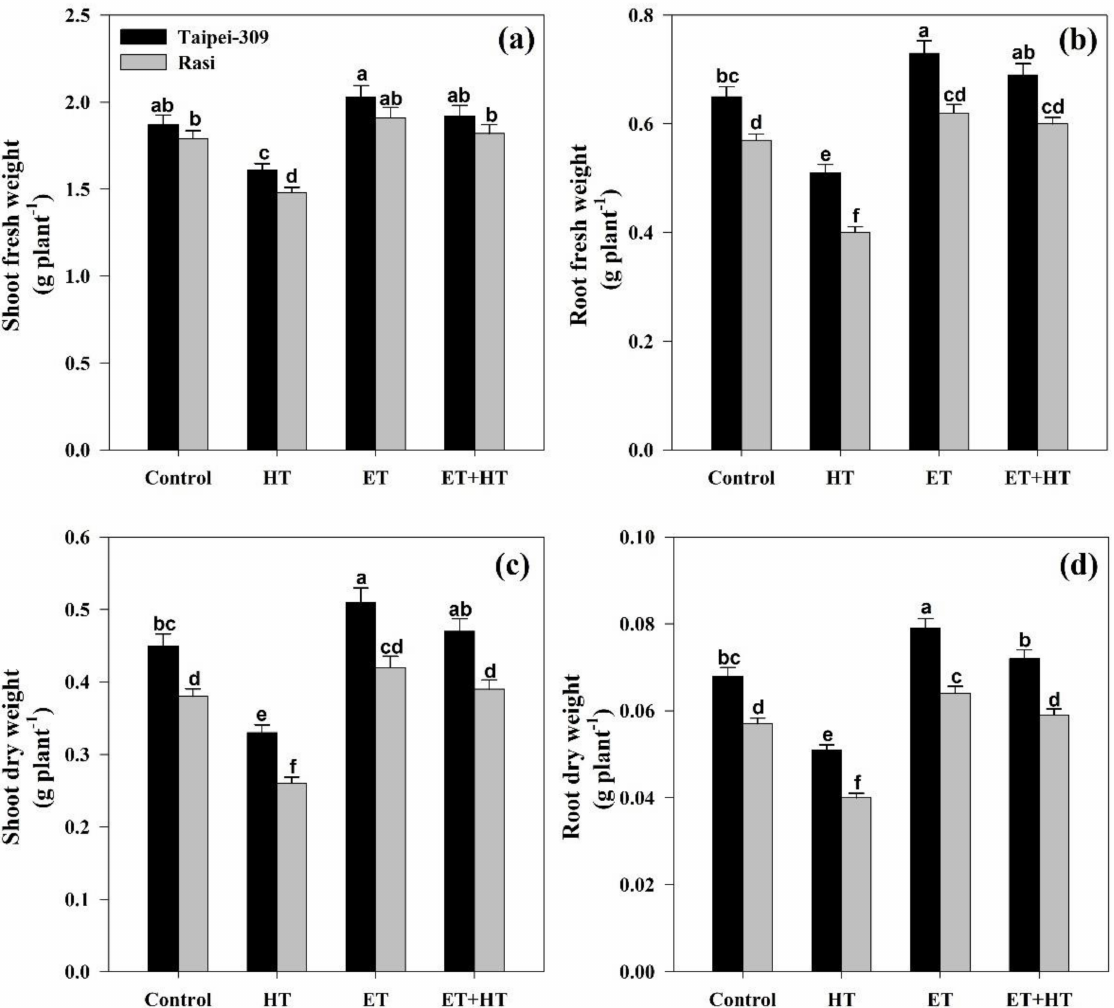
Figure 3. ( a ) Shoot fresh weight, ( b ) root fresh weight, ( c ) shoot dry weight, and ( d ) root dry weight in Taipei-309 and Rasi cultivars of rice ( Oryza sativa L.) at 30 DAS. Plants were grown with/without high-temperature (HT) stress and treated with a foliar spray of 1.6 mM ethephon (ET) at 15 DAS. Data are presented as treatment means ± SE ( n = 4). Bars with the same letters did not differ significantly by the LSD test at p < 0.05. DAS, days after